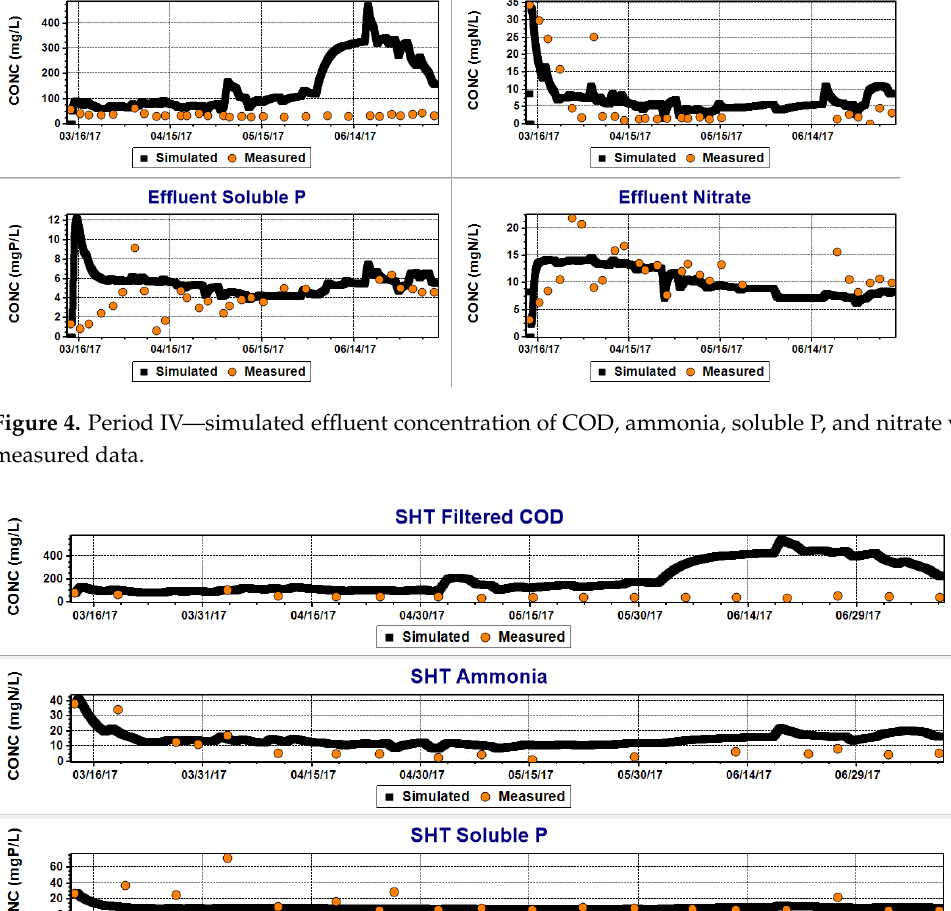
Figure 5. Period IV — SHT simulated concentration of COD, ammonia, and soluble P vs. measured Figure 5. Period IV—SHT simulated concentration of COD, ammonia, and soluble P vs. mea-